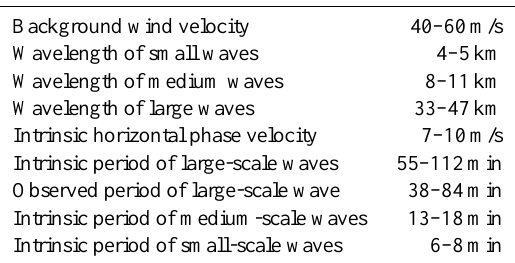
Table 1. Wave parameters in the NLC area estimated with pho- togrammetric technique.